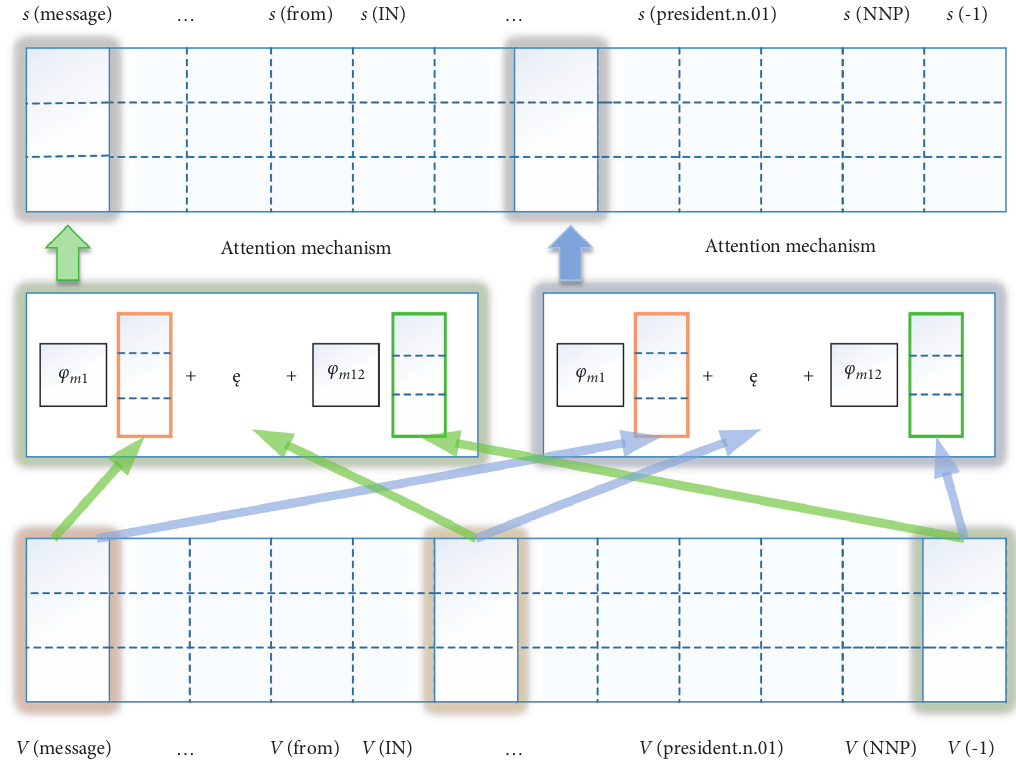
Figure 3: Attention operation